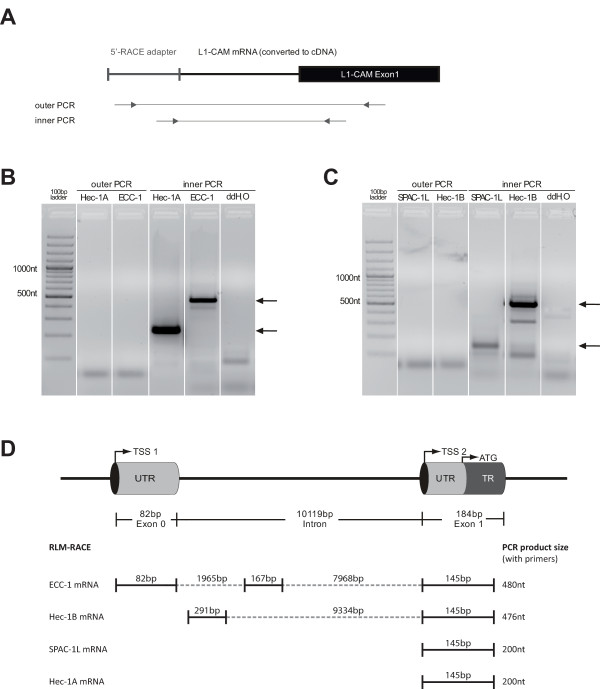
RLM-RACE to determine transcription start sites in endometrial carcinoma cell lines. (A) Schematic outline of the RLM-RACE reaction consisting of the ligation of the 5'RACE-adaptor followed by 2 nested PCR reactions with outer and inner primers. (B and C) RNA preparations of Hec-1A, ECC-1, SPAC-1L, and Hec-1B cells were subjected to the RLM-RACE analysis. On the agarose gel the products of the nested PCR reactions obtained after outer (no product because of low copy number) and inner PCR are shown. Note the different size of amplified products. The water control served as a negative control without template. (D) Amplified bands were excised from the gel and subjected to DNA sequencing. The resulting products and the respective TSS are schematically indicated.